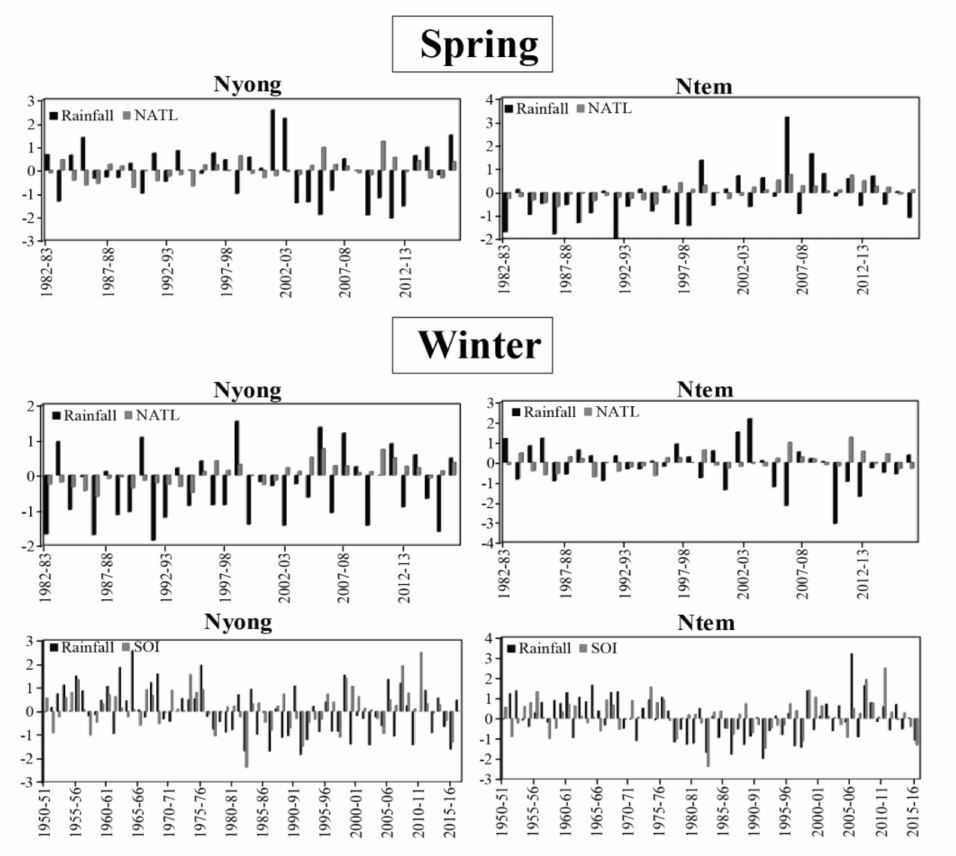
Figure 5. Comparison of climatic indices and normalized rainfall